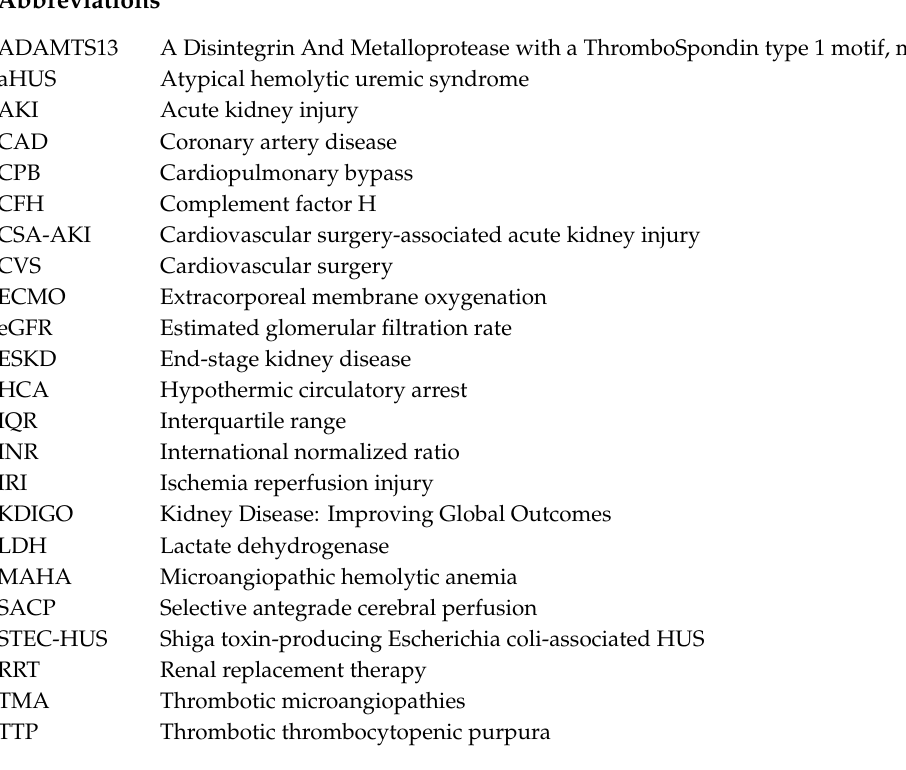
Figure S1: In-hospital evolution of kidney function (baseline vs discharge), Table S1: Postoperative